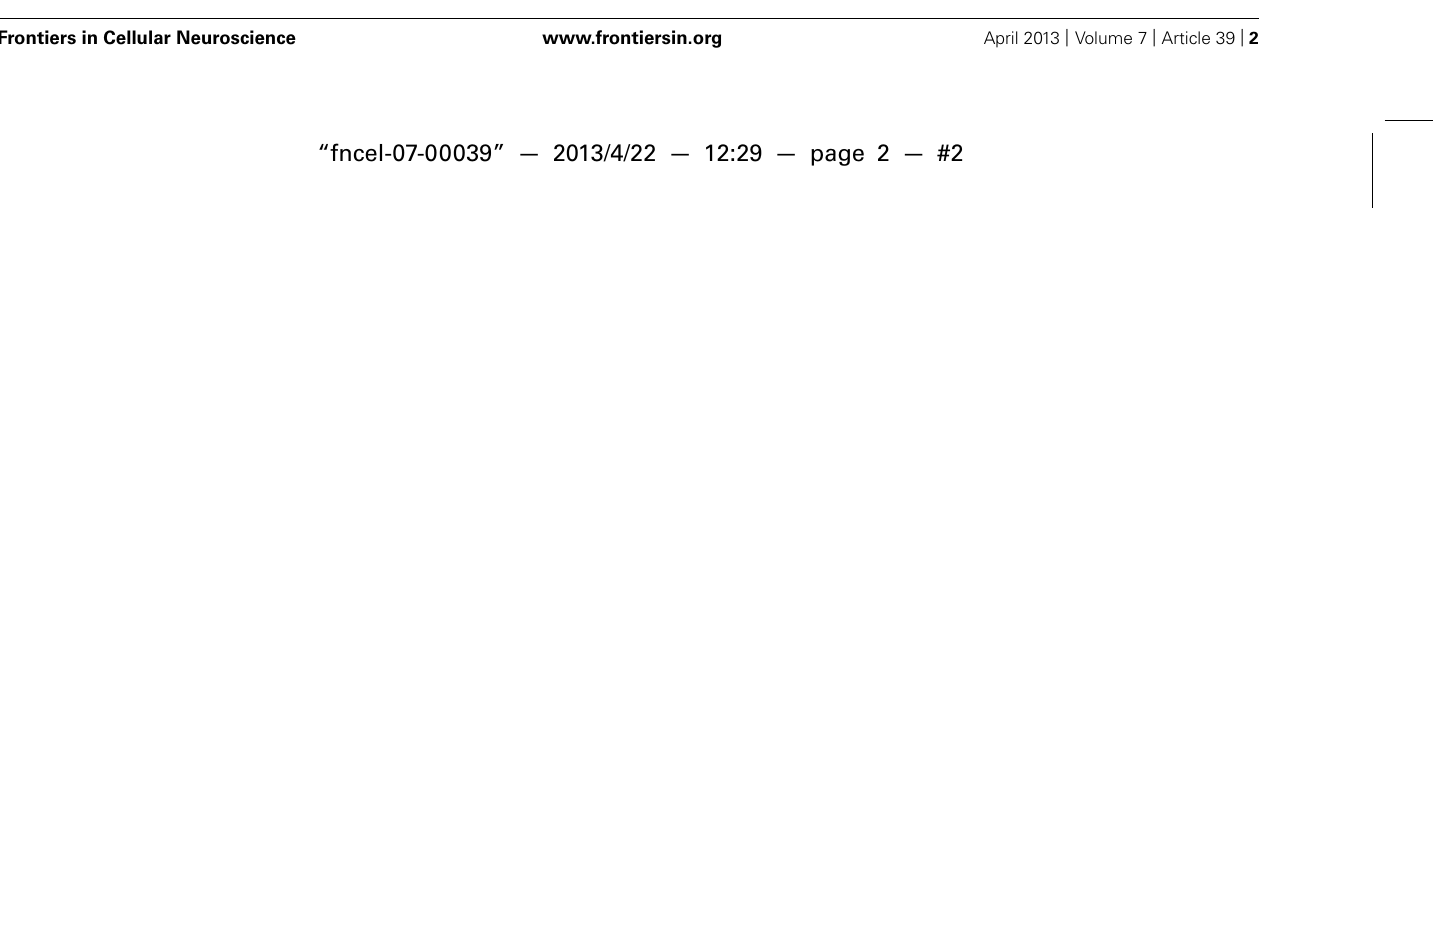
hippocampus; PM, pons/medulla; Sn, substantia nigra; Sp, spinal cord; WM, white matter;VNL, vomeronasal nerve layer. Figure modified from Schell etal.